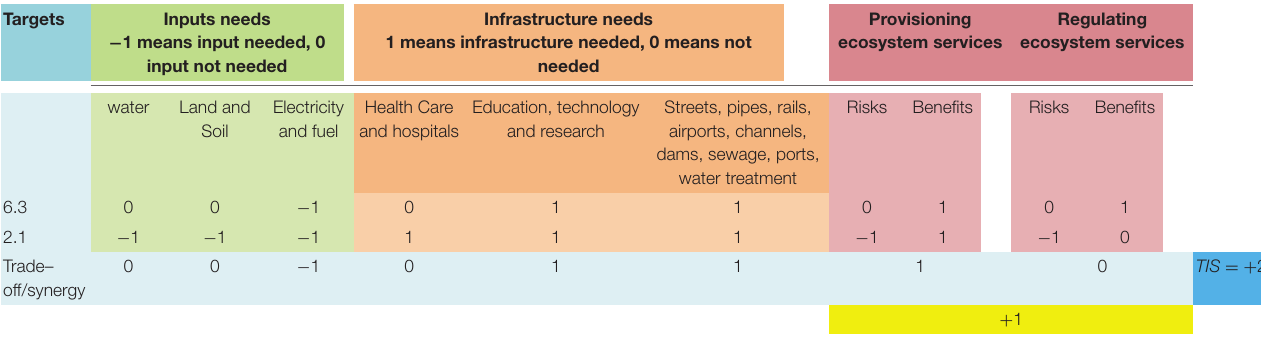
TABLE 2 | Example of two targets interaction assessment. Targets